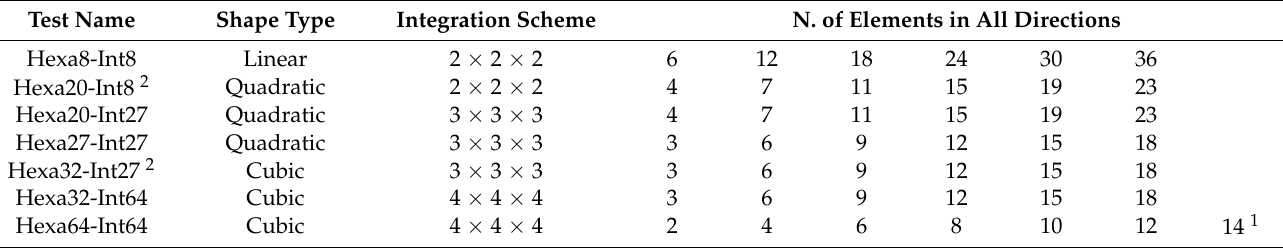
Table 3. FE formulations considered in the comparative analysis.